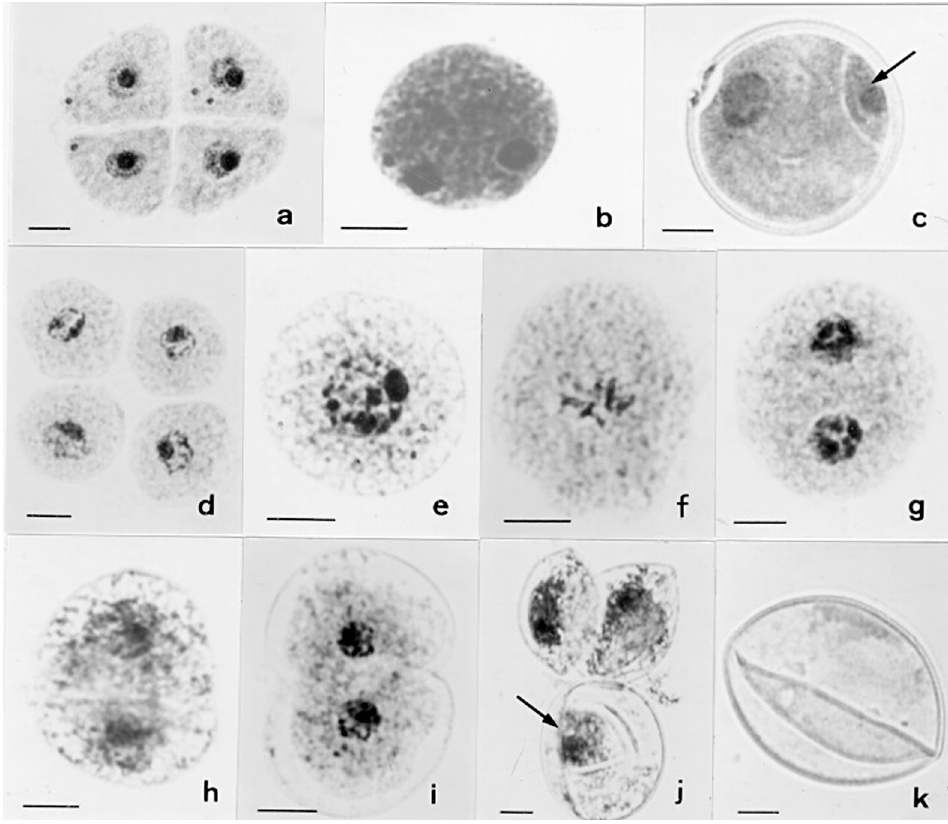
Figure 1. Pollen development in Brachiaria jubata (BRA 007820 ). a , Normal tetrad with several mi- cronuclei in microspores. b , Nor- mal pollen mitosis (PM I): telo- phase. Note the polarized nu- cleus position. c , Pollen grain after a normal and asymmetric PM I. Observe the typical hemi- spherical cell plate between the generative (arrow) and the veg- etative cells. d , Tetrad after cal- lose dissolution. e , Abnormal re- leased microspore without nu- cleus polarization. f, g, Symmet- ric PM I: metaphase (f) and telo- phase (g). Observe the lack of displacement of cell division from the cell center. In telophase (g), note that both nuclei are of equal sizes and chromatin is equally condensed. h , Cytokine- sis after telophase dividing the microspore into two equal-sized cells. i , Two uninucleate sister pollen grains. j , Two sister pollen grains flanked by a normal one (arrow). Note that the normal pol- len grain is double the size of those resulting from symmetric PM I. k , Sterile pollen grain. (Scale bars = 0.5